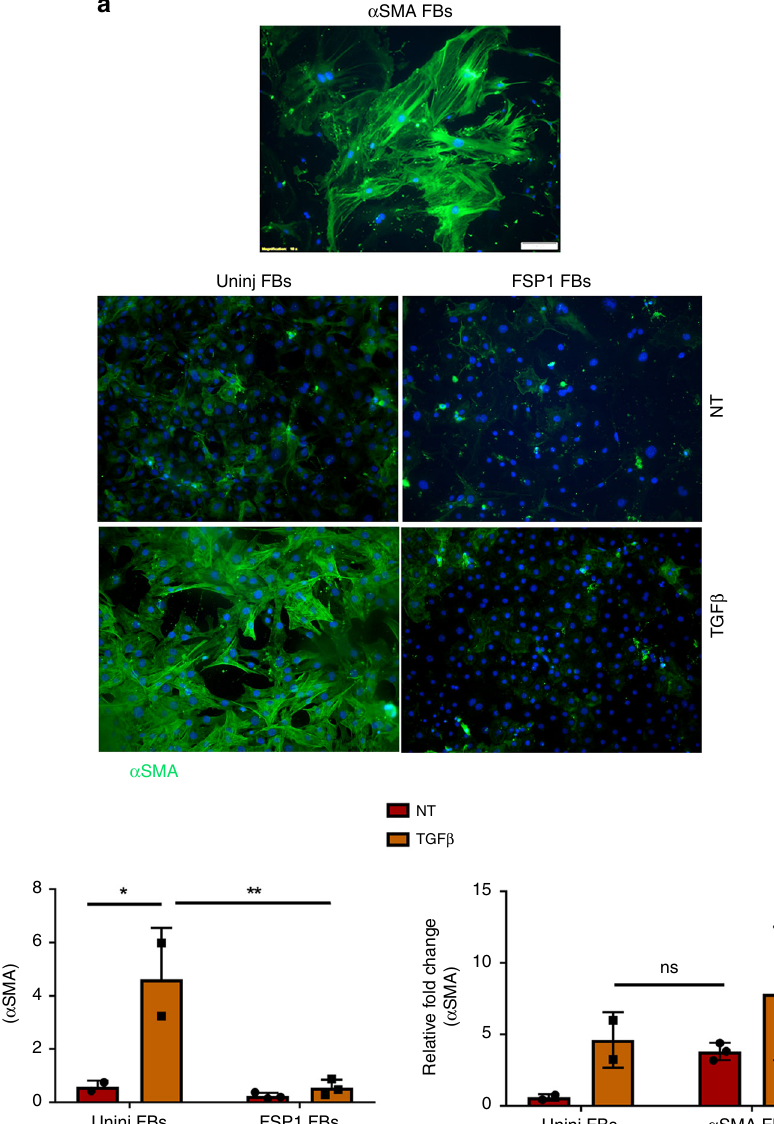
Fig. 4 FSP1 + fi broblasts do not differentiate into α SMA-expressing fi broblasts. a . Immuno fl uorescence staining for α SMA protein in fi broblasts (P0) isolated from uninjured and FSP1-GFP mice hearts 10 days post injury and cultured for 72 h in the presence or absence of TGF β . Nuclei were stained with DAPI ( n = 3). α SMA + fi broblasts isolated from α SMA-GFP mice post injury were used a positive control (P0). Scale bar = 100 µ M; ×10 magni fi cation b Relative fold change of α SMA expression in both uninjured fi broblast and FSP1 + fi broblasts (P3 – P5) cultured with or without TGF β , * p < 0.05; ** p < 0.005; ns p > 0.05 was calculated by two-way ANOVA, n = 2 experiments for uninjured fi broblasts and n = 3 experiments with FSP1 + and α SMA + fi broblasts were performed; bar represents mean ± SD; ns = not signi fi